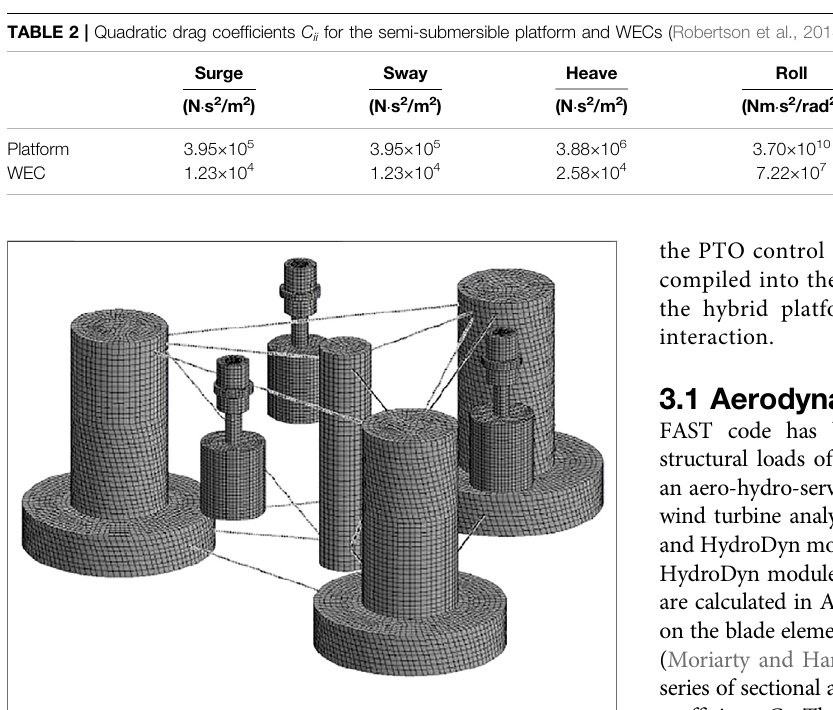
FIGURE 3 | Generated mesh of the hybrid platform and